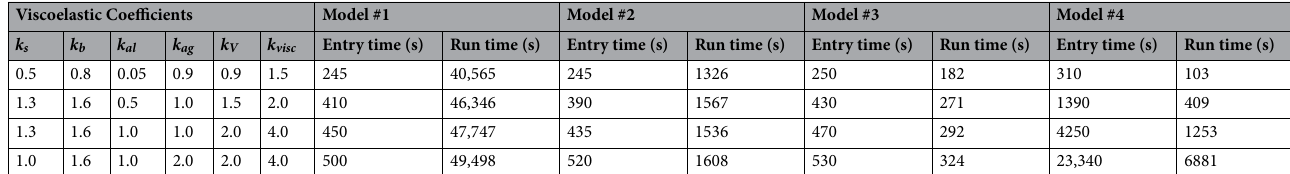
Table 4. Comparison of the four models in Fig. 1 in terms of entry time and run time for four combinations of viscoelastic parameters.